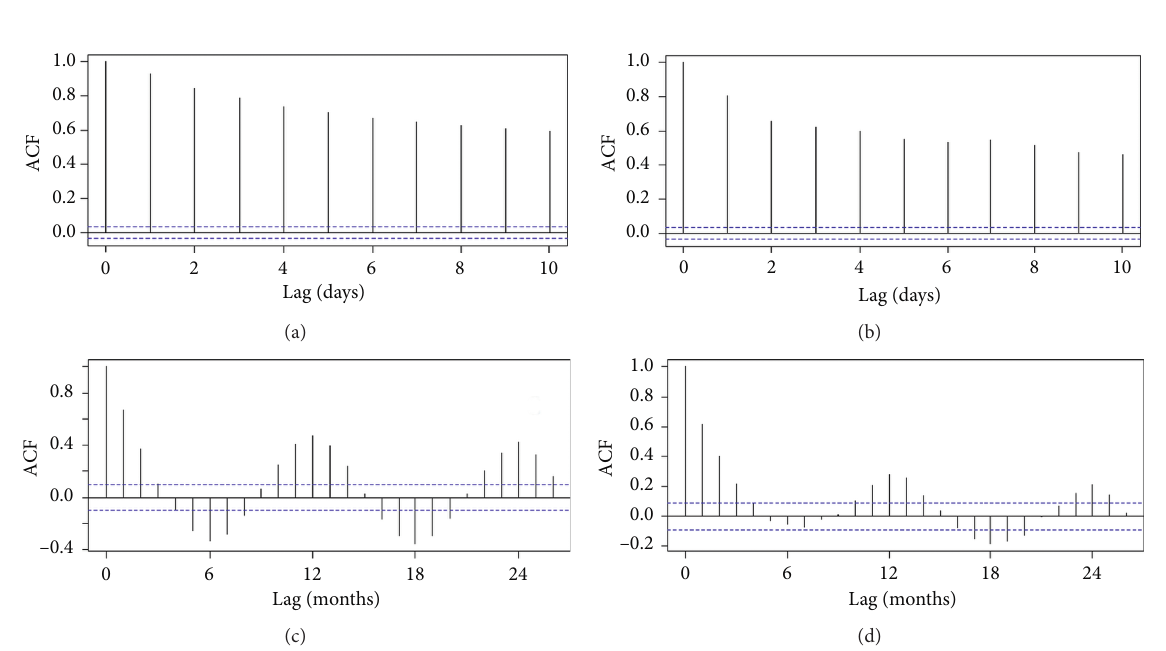
Figure 2: Time series ACF plots for (a, c) Trinity and (b, d) West